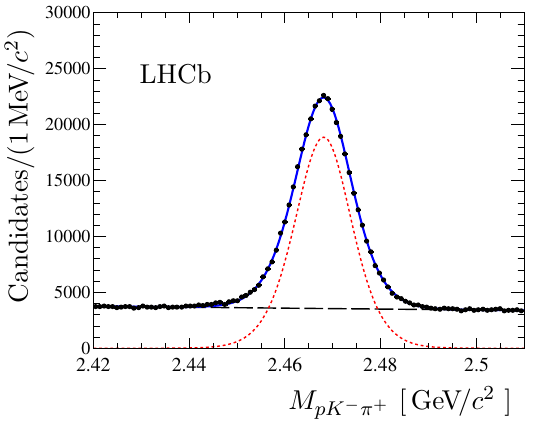
Figure 3 . Fit results for the (cid:4) + ! pK (cid:0) (cid:25) + decay. The red dotted line corresponds to the signal c component, the black dashed line re(cid:13)ects the background distribution and the blue solid line is their